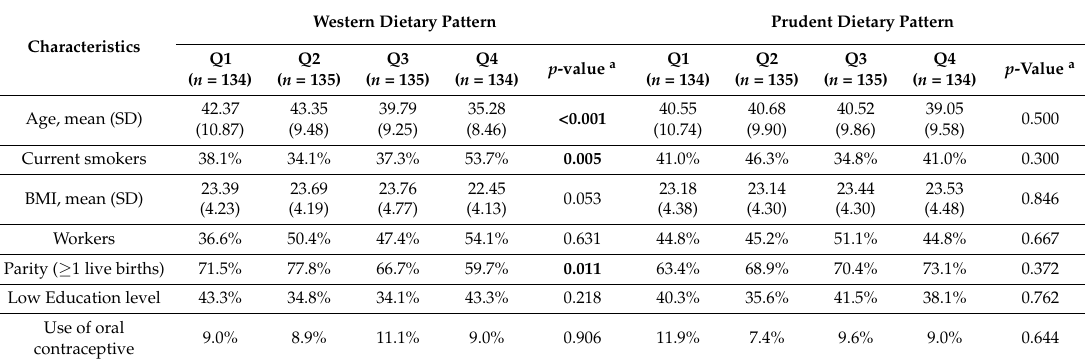
Table 3. Characteristics of women according to dietary pattern